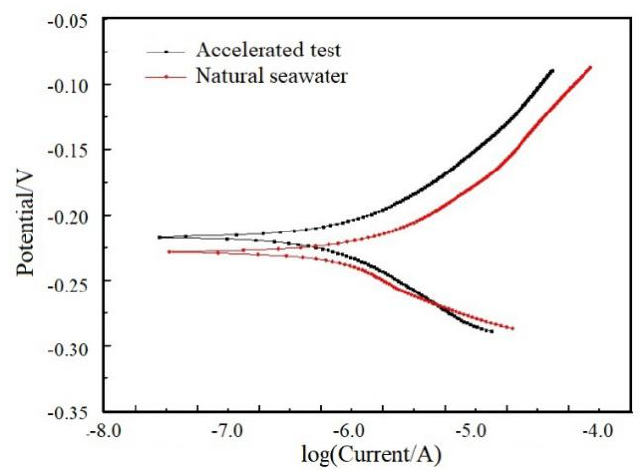
Figure 10. The polarization curve in natural seawater and in laboratory accelerated test.